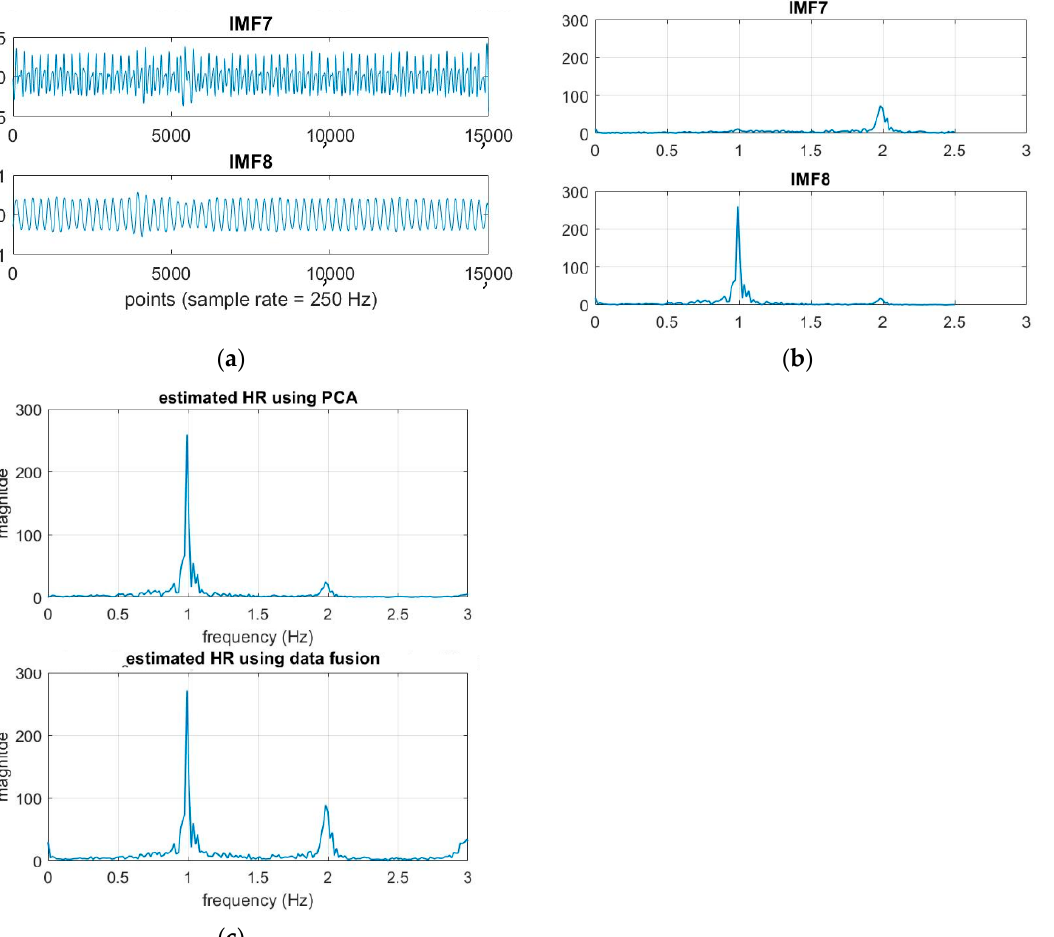
Figure 9. ( a ) The time series of the cardiac group; ( b ) the spectra of the time series; ( c ) the estimated HR using EEMD-PCA and EEMD-SDF.